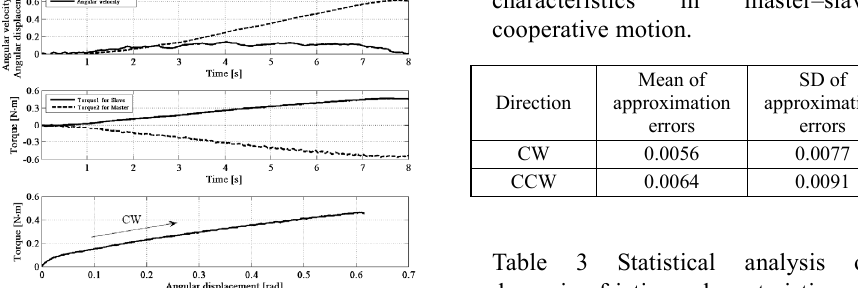
3 Statistical analysis of dynamic friction characteristics